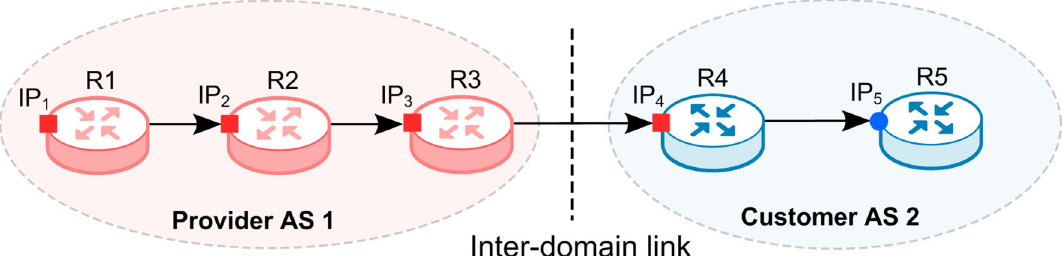
Figure 3. Example of p2c link in which the provider supplies the address space.